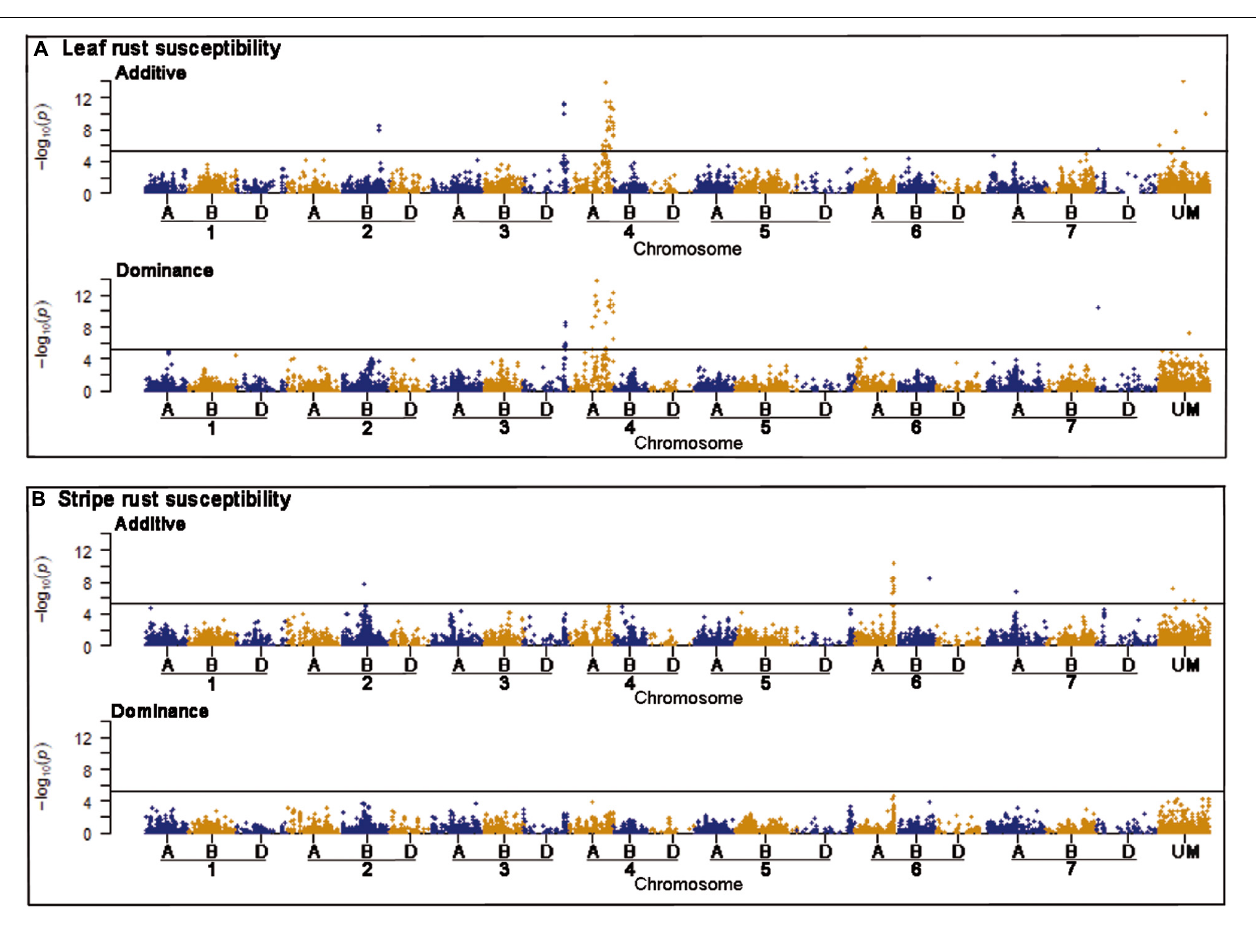
FIGURE 2 | Manhattan plots of the genome-wide association scans for additive and dominance effects on leaf rust (A) and stripe rust resistance (B) . The horizontal line symbolizes the significant threshold of P < 0.05 applying Bonferroni correction. The hexaploid genome of bread wheat consists of 42 chromosomes combining the complete chromosomal sets of three different wild grasses, which are differentiated by the letters A, B, and D. The x -axis shows chromosomal location of the corresponding markers, while UM are unmapped